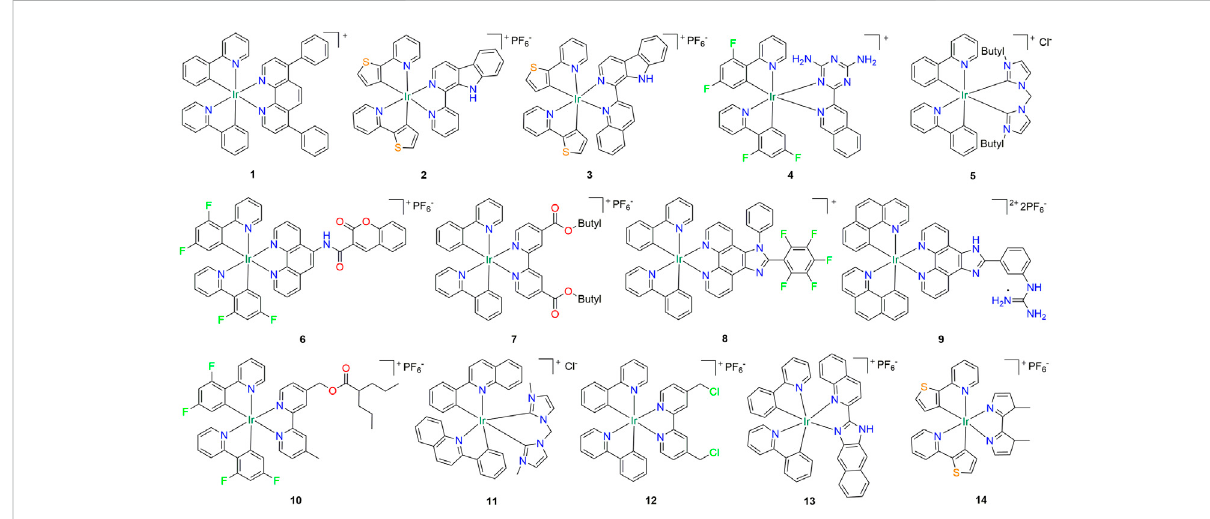
FIGURE 1 Structure of anti-lung cancer cyclometalated Iridium (III) compounds ( 1 – 14 ).